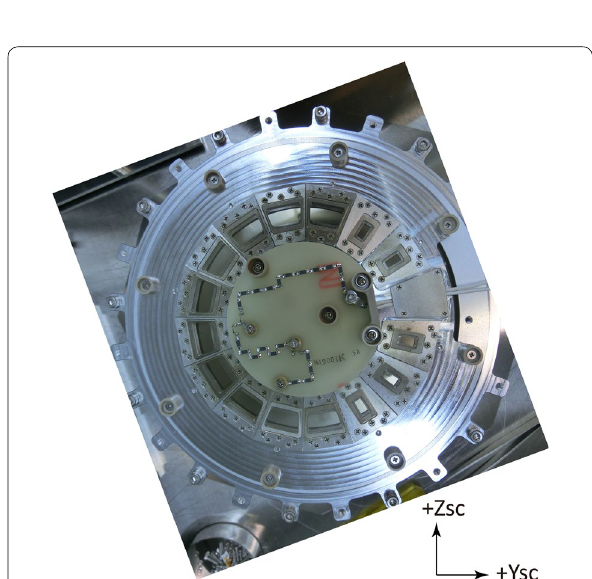
Fig. 7 Picture of the entrance of the TOF section. Foil holders with ultra-thin carbon foils are installed at the